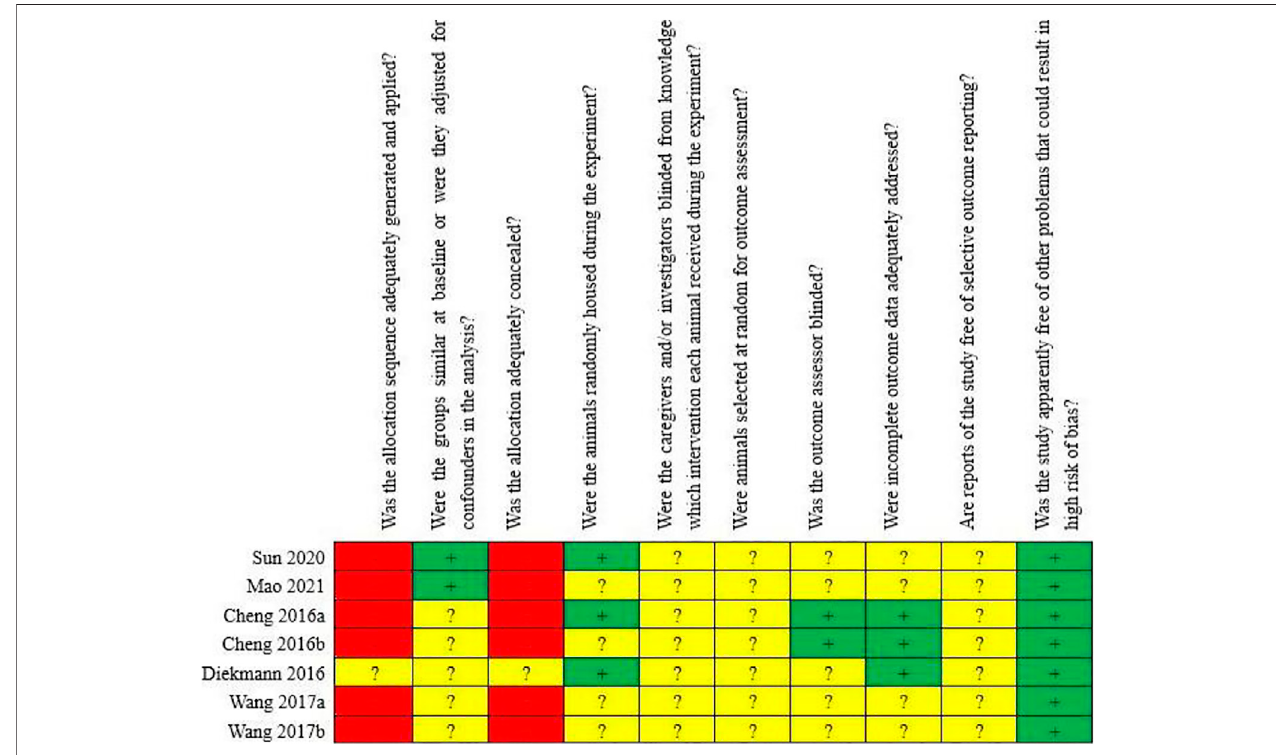
FIGURE 2 | Risk of bias of the individual included animal studies. The items were scored with “ yes, ” “ no, ” “ unsure. ”